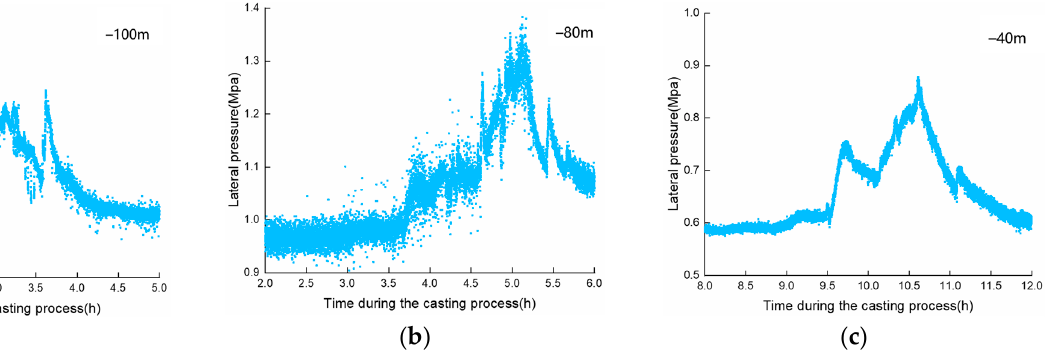
Figure 4. Development of lateral pressure during the filling process (partial enlarged view). ( a ) The depth of the measurement point is 100 m; ( b ) the depth of the measurement point is 80 m; ( c ) the depth of the measurement point is 40 m. Table 3. Casting time per truck and effective lateral pressure before and after the peak at each monitoring